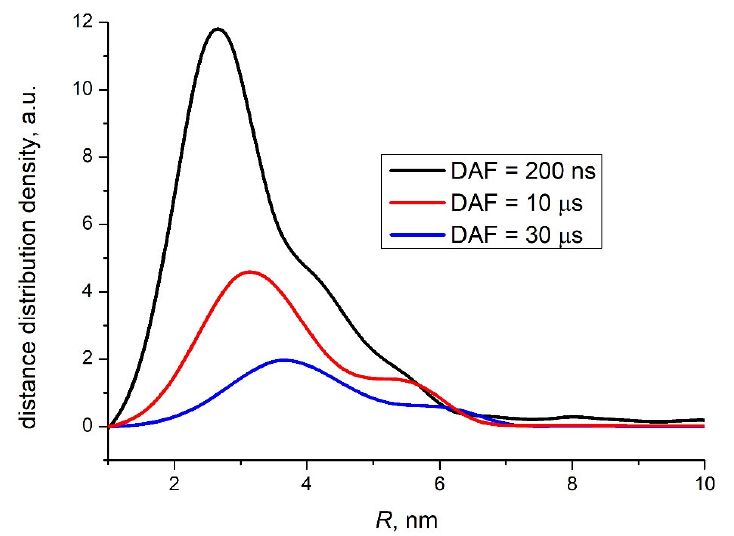
Figure 4. The interspin distance distribution density for the CTS P3HT + /s-SWCNT − obtained from numerical simulation of the out-of-phase ESEEM traces for different DAF values: black line—200 ns, red line—10 μ s, blue line—30 μ s.